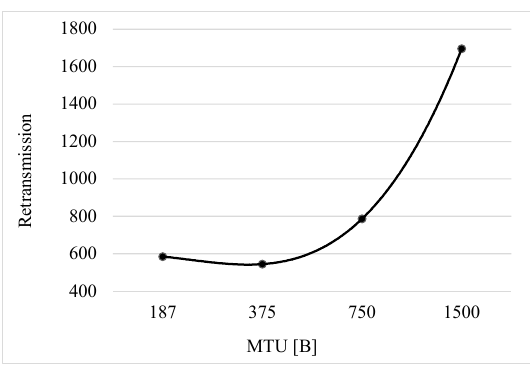
Figure 6. The number of retransmissions with respect to packet length.